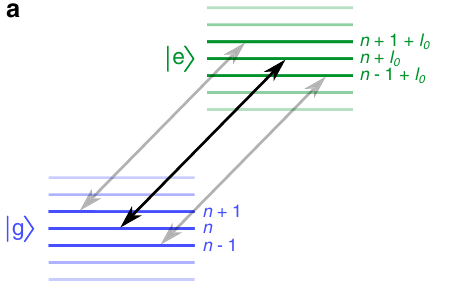
Fig. 1 | Couplings between the magic wavelength optical dipole trap motional states, induced by the excitation light. a When the excitation light contains a singlefrequency,onlypairsofmotionalstateswitha fi xedenergydifference(equal to ℓ 0 vibrational quanta) are coupled (carrier transitions, fi gured as black and gray